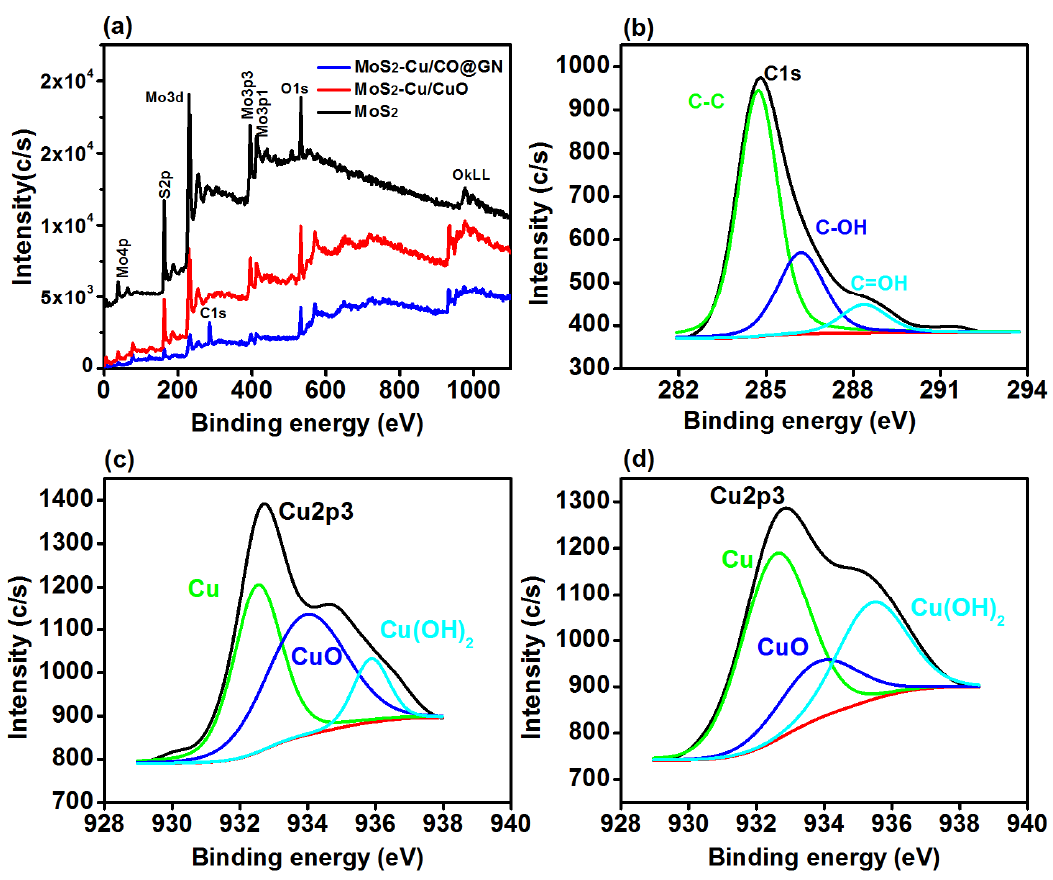
Figure 3. ( a ) Survey scan for MoS 2 , MoS 2 -Cu/CuO and MoS 2 -Cu/CuO@GN, ( b ) high resolution C1s spectra of MoS 2 -Cu/CuO@GN and ( c , d ) high resolution Cup2 analysis for MoS 2 -Cu/CuO and MoS 2 -Cu/CuO@GN.